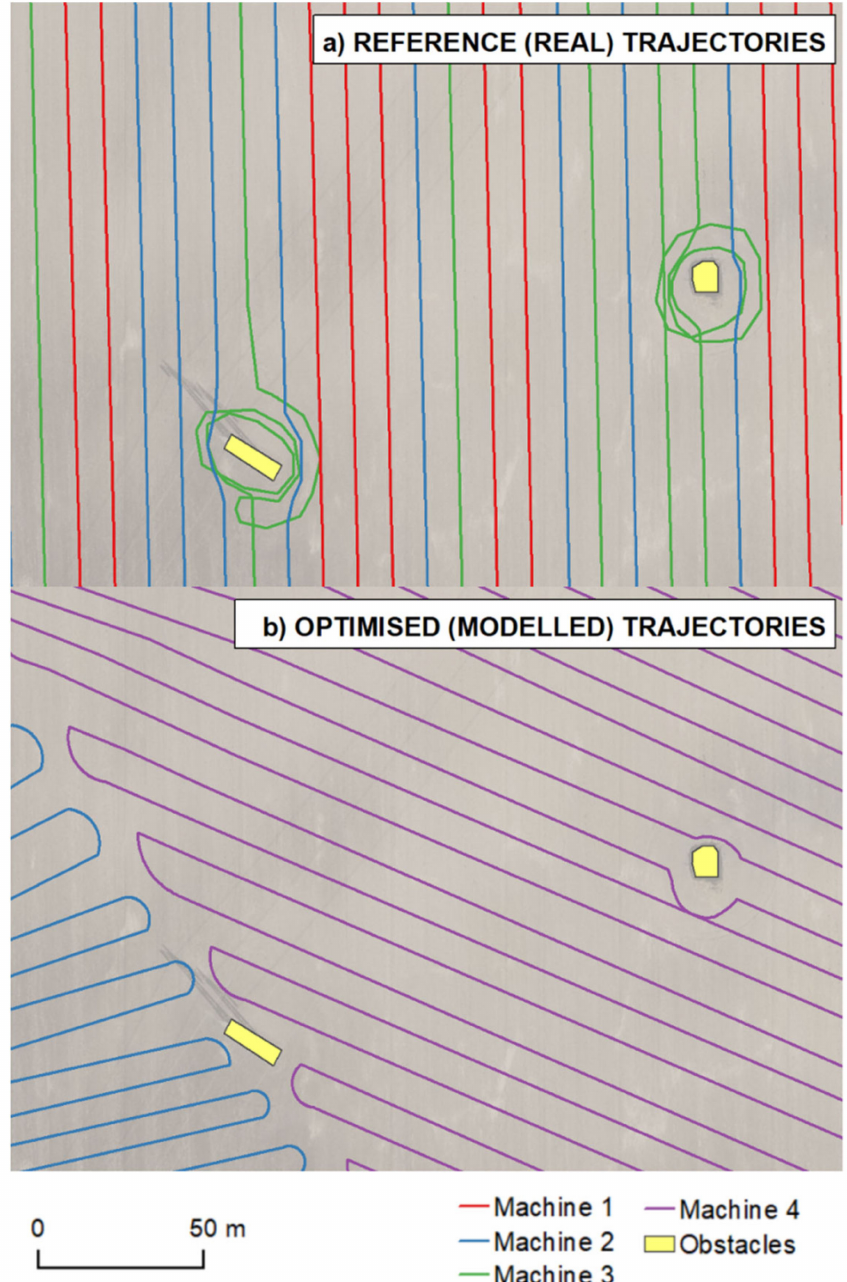
Figure 5. Examples of obstacle avoidance in reference (real) trajectories ( a ) and optimal trajectories ( b ). Note that the left obstacle in the left image lies on the border of trajectories in the right